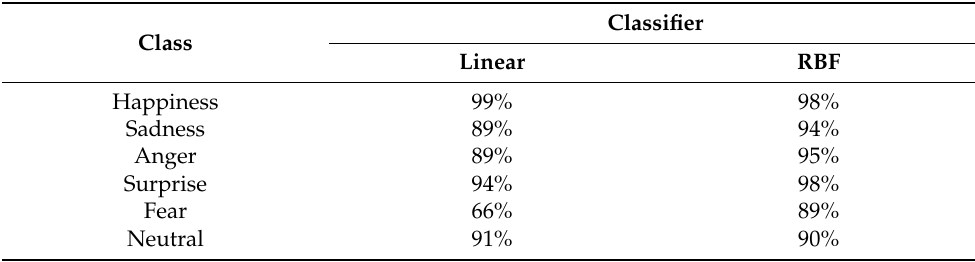
Table 3. Comparison of the accuracies per class between the SVM with a linear kernel and RBF kernel. Classifier Class Linear RBF 99% 98%